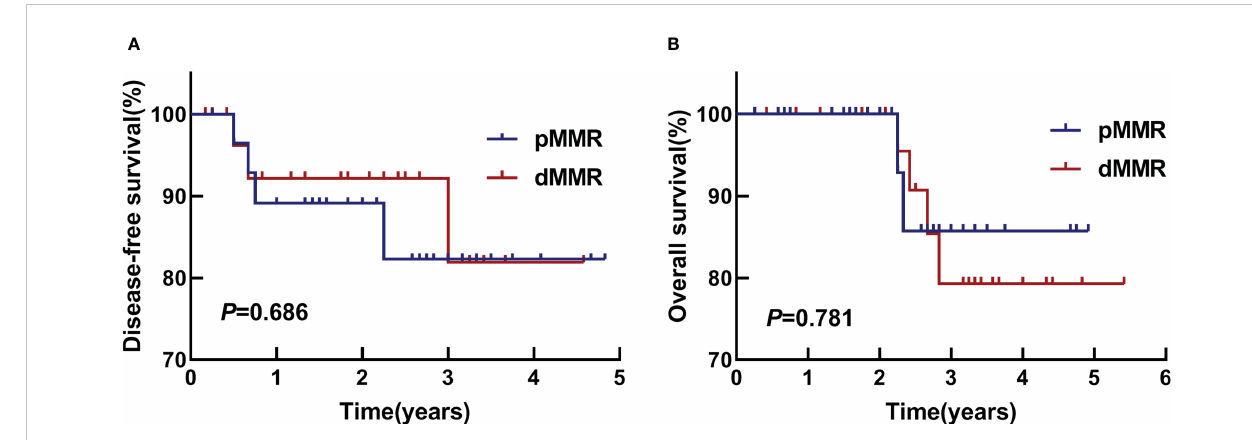
FIGURE 5 DFS and OS. (A) Kaplan-Meier survival analyses of DFS in two groups, P =0.686. (B) Kaplan-Meier survival analyses of OS in two groups, P